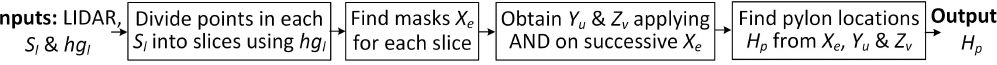
Figure 6. The work flow for detecting pylon